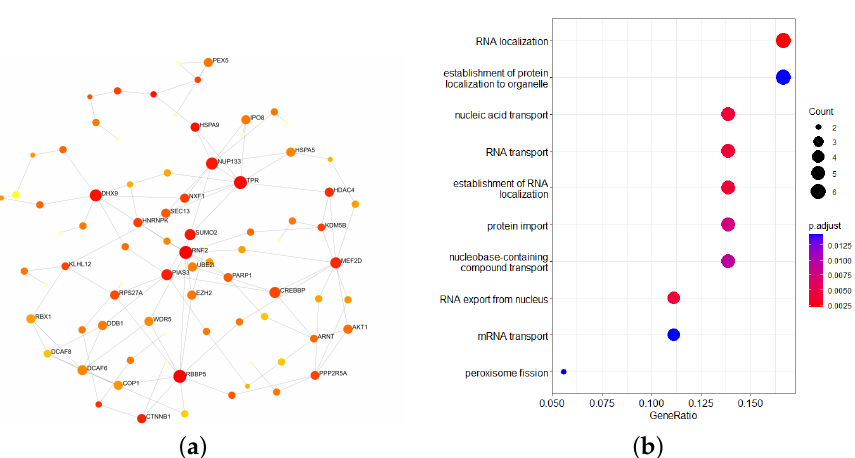
Figure 4. ( a ) The minimal network of the 97-gene PPI network of the pink module. ( b ) Visualization of the top ten items of the GO enrichment analysis